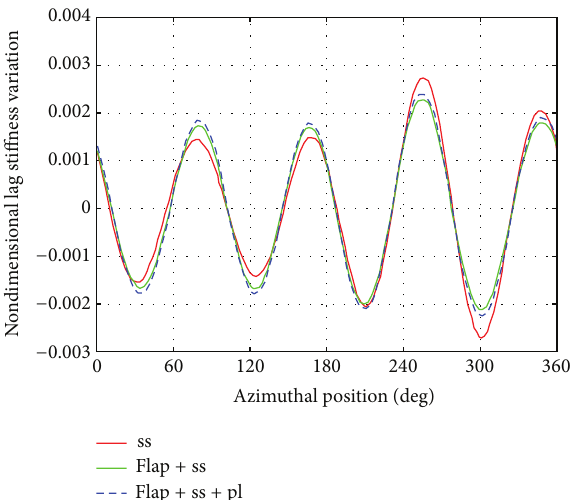
Figure 8: Hub loads without feedback, Drees synthesis, and free- wake inflow